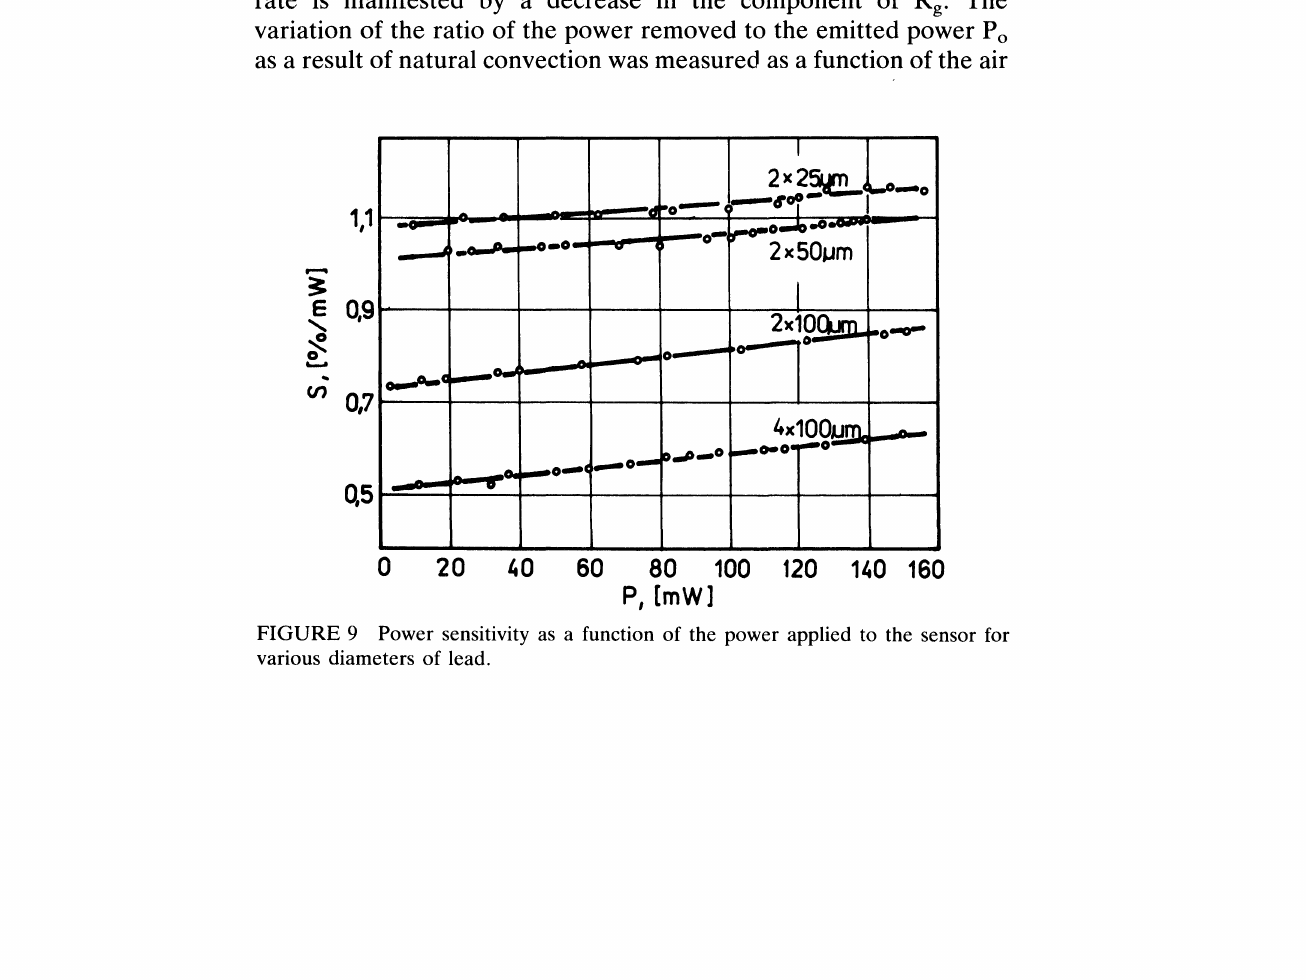
FIGURE 9 Power sensitivity as a function of the power applied to the sensor for various diameters of